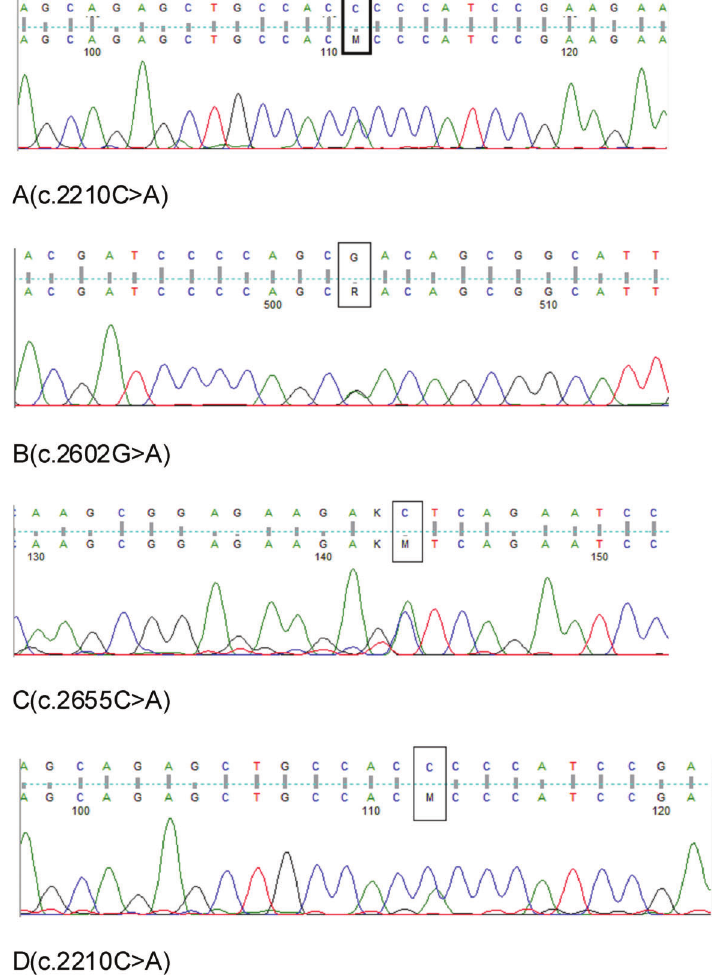
Figure 2. SETBP1 mutations (boxed) present in the son ( A - C ) and the father ( D ). Upper rows indicate normal sequences, and lower rows indicate patient sequences.